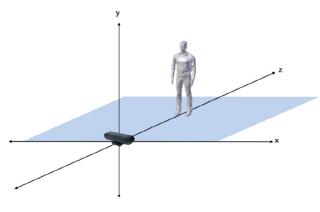
Figure 4. The axis topology.